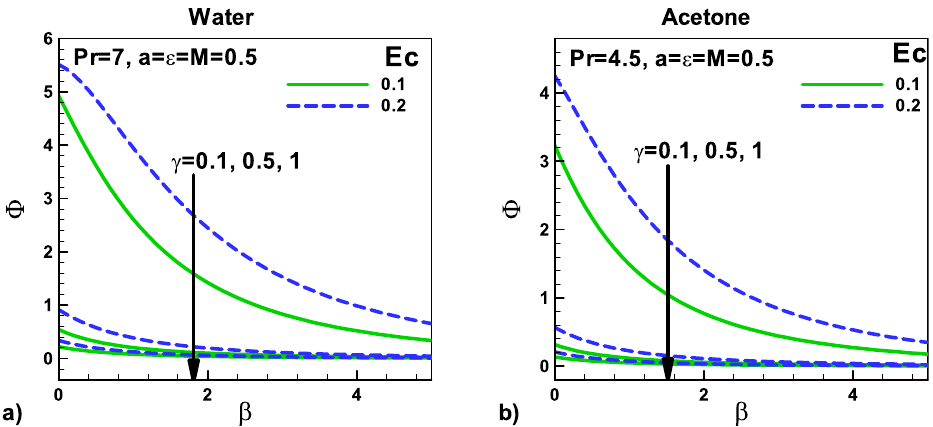
Figure 17. Variation of irreversibility ratio with velocity and thermal slip parameters for ( a ) water ( b )